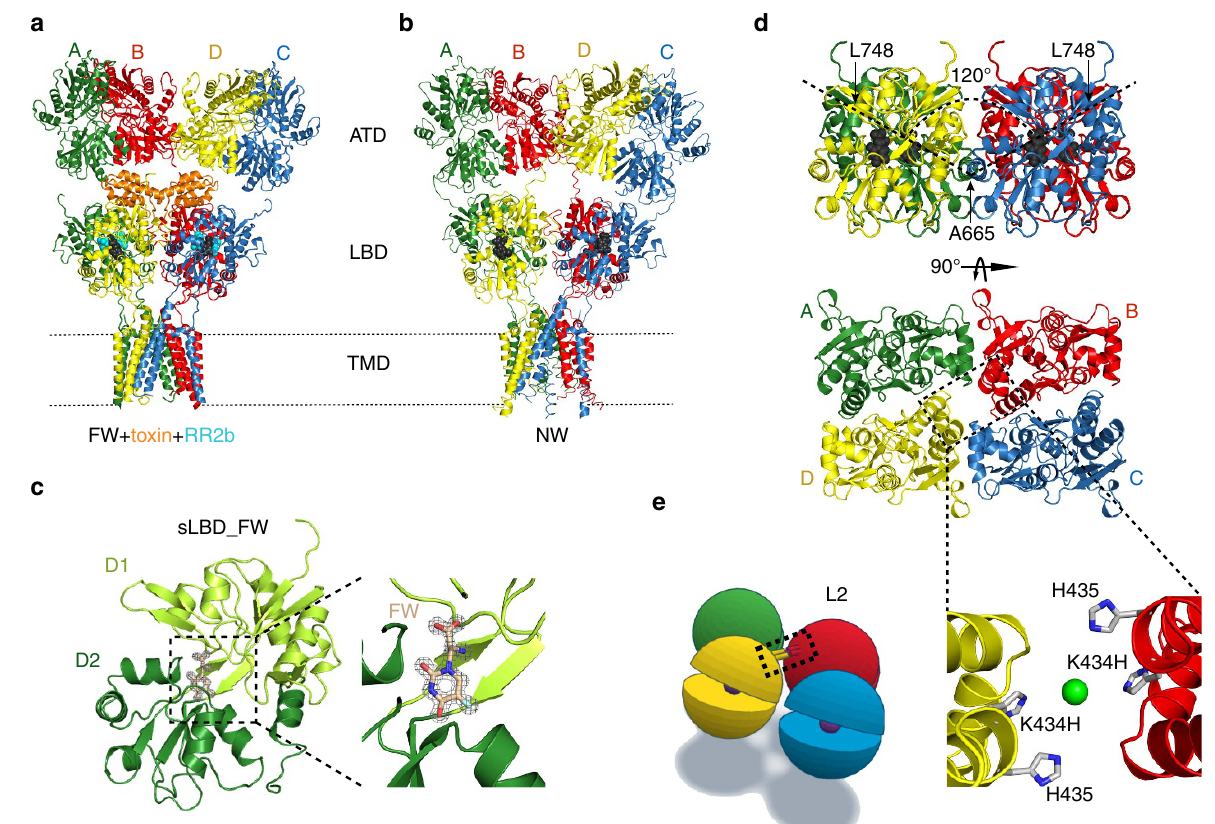
Figure 1 | Structure of the GluA2 LBD tetramer bound by FW. ( a ) Side view of the GluA2-toxin-(R,R)-2b-FW complex (PDB: 4u5c), with the subunits coloured as follows: A (green), B (red), C (blue) and D (yellow). The Con-Ikot-Ikot toxin is shown in orange and the agonist fluorowillardiine (FW) and the modulator (R,R)-2b are represented in black and cyan spheres, respectively. ( b ) The GluA2 NW structure (PDB: 4u4f) represented as in a . The partial agonist nitrowillardiine is coloured in black spheres. ( c ) Crystal structure of the soluble LBD in complex with FW (sLBD_FW) at 1.23Å resolution. Domain 1 (light green) and domain 2 (green) harbour the agonist binding site. The inset shows the positive difference electron density omit map around FW contoured at 2 sigma. ( d ) The upper panel shows the tetrameric sLBD_FW structure oriented as in the full-length structures presented in A and B. FW is shown as black spheres. The relative dimer orientation of 120 (cid:2) is measured by the angle between the centre of mass between Ala665 and Leu748 of subunits A and C. The lower panel shows the top view (turned 90 (cid:2) along the x-axis) onto the crystal structure of sLBD_FW, which forms a tetramer with its symmetry mates. ( e ) In the left panel a cartoon showing the localization of the mutant L2, which was used to validate the sLBD_FW structure is presented. According to the histidine mutation model based on our sLBD_FW structure (right panel) the L2 mutant should trap between the subunits B (red) and D (yellow). To probe this interface, a binding site for Zn 2 þ was introduced by using the native histidine at position 435 and replacing residue K434 for a histidine. The fictive Zn 2 þ ion is shown as a green sphere and was manually placed between the four